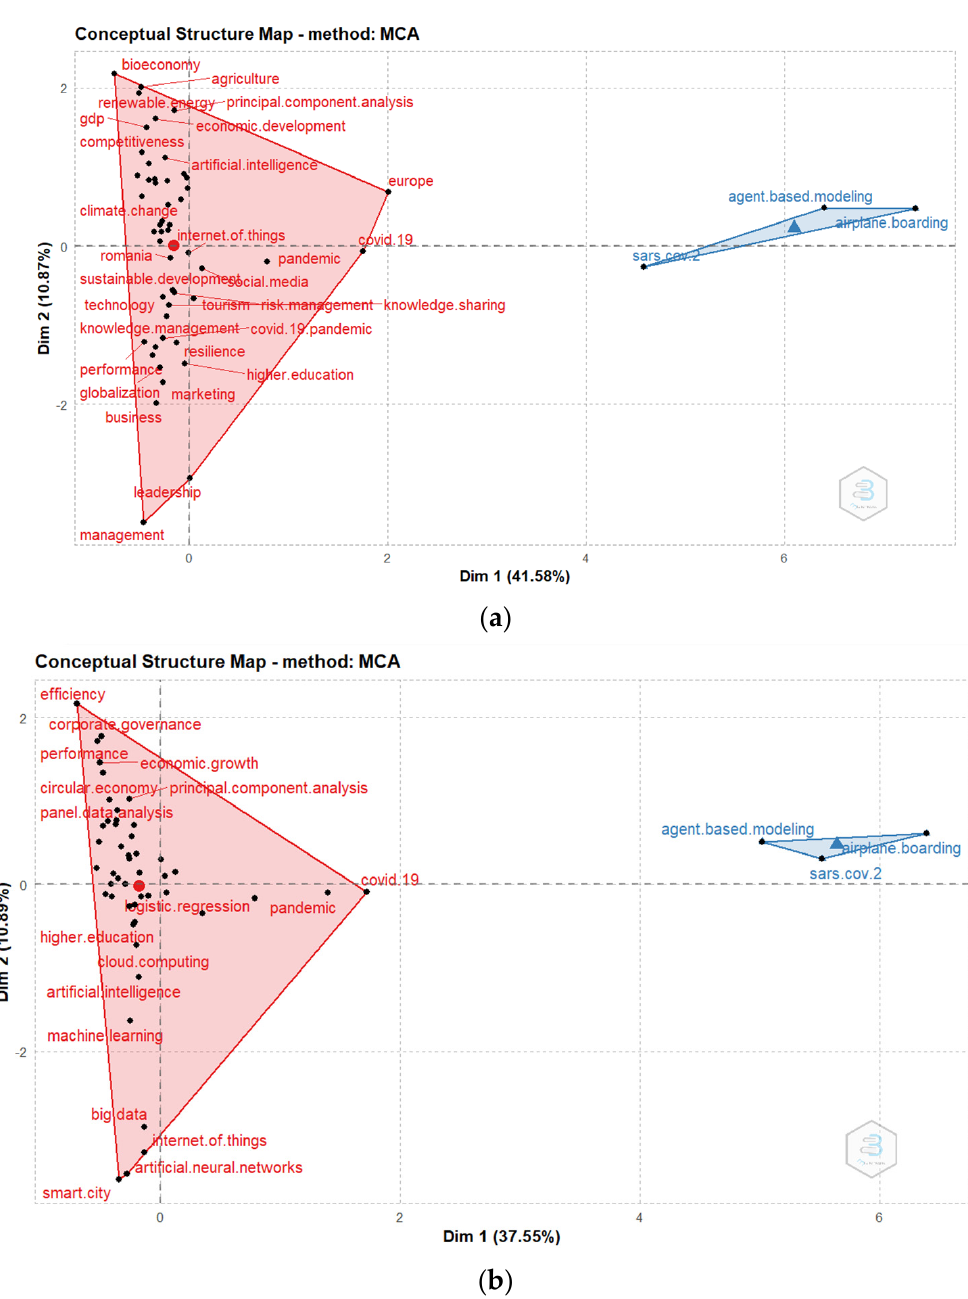
Figure 11. Conceptual structure map of Bucharest University of Economic Studies researchers. ( a ) WoS. ( b ) Scopus.